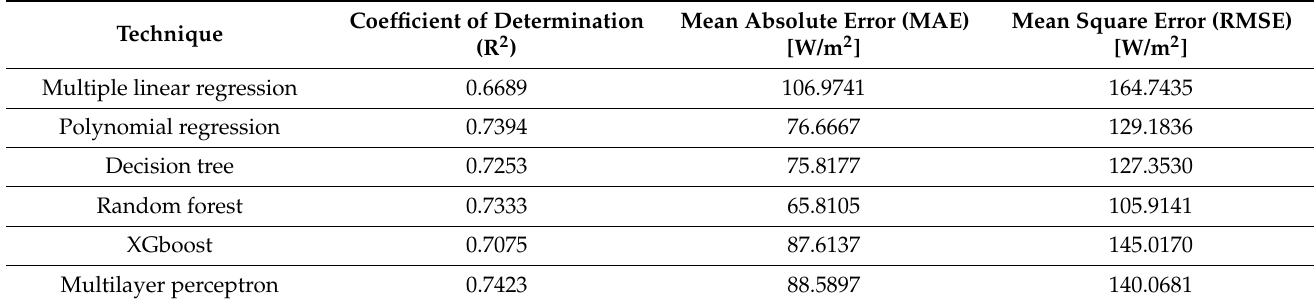
Table 9. Evaluation metrics for solar radiation